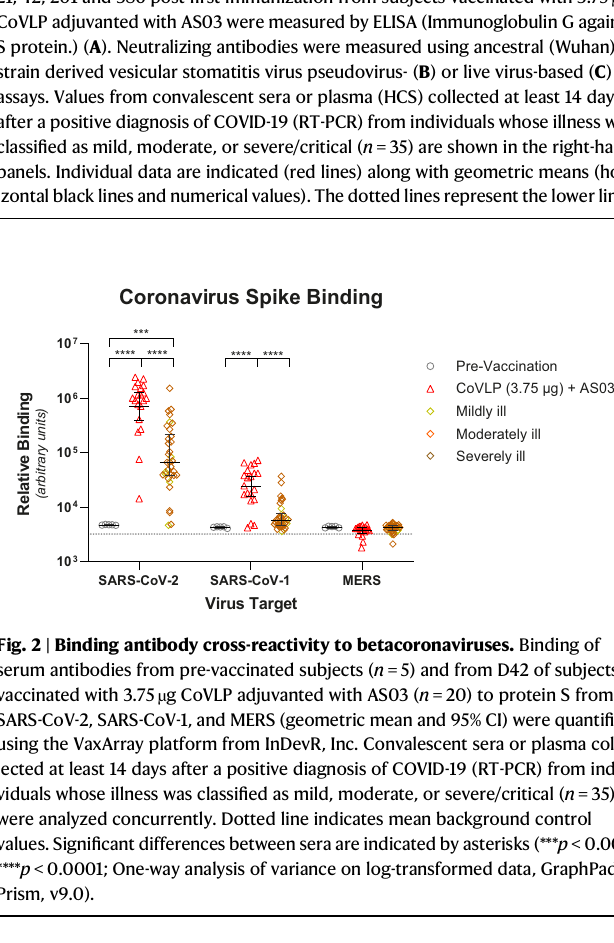
of detection.Forpanel A ,vaccinatedsubjectsatD0and 21( n =20);atD42( n =19); at D201 ( n =18); at D386 ( n =8) and HCS ( n =34) were included. For panel B , vaccinated subjects at D0 and D21 ( n =20); at D42 ( n =18); at D201 ( n =18); at D386( n =8)andHCS( n =35)wereincluded.Forpanel C ,vaccinatedsubjectsatD0 and D21 ( n =20); at D42 ( n =19); at D201 ( n =18); at D386 ( n =8) and HCS ( n =35) were included. Error bars indicate 95% CI. Black triangles indicate immunization. Signi fi cant differences between timepoints are indicated by asterisk(s) (* p <0.05; **** p <0.0001; One-way analysis of variance using a mixed-effect model on log-